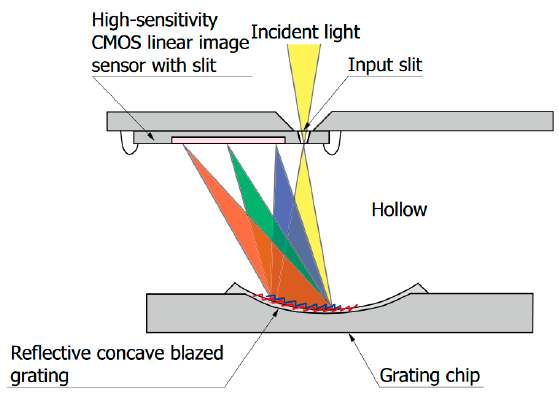
Figure 2. The internal structure of the MEMS spectrometer [23].